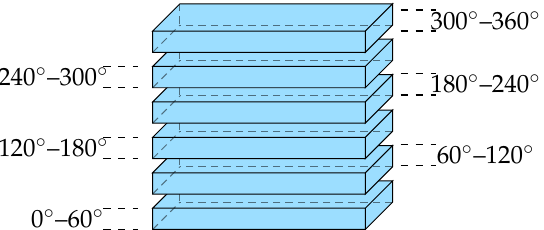
Figure 1. Evenly distributed airspace structure; the total heading range (360 ◦ ) is divided per the available traffic